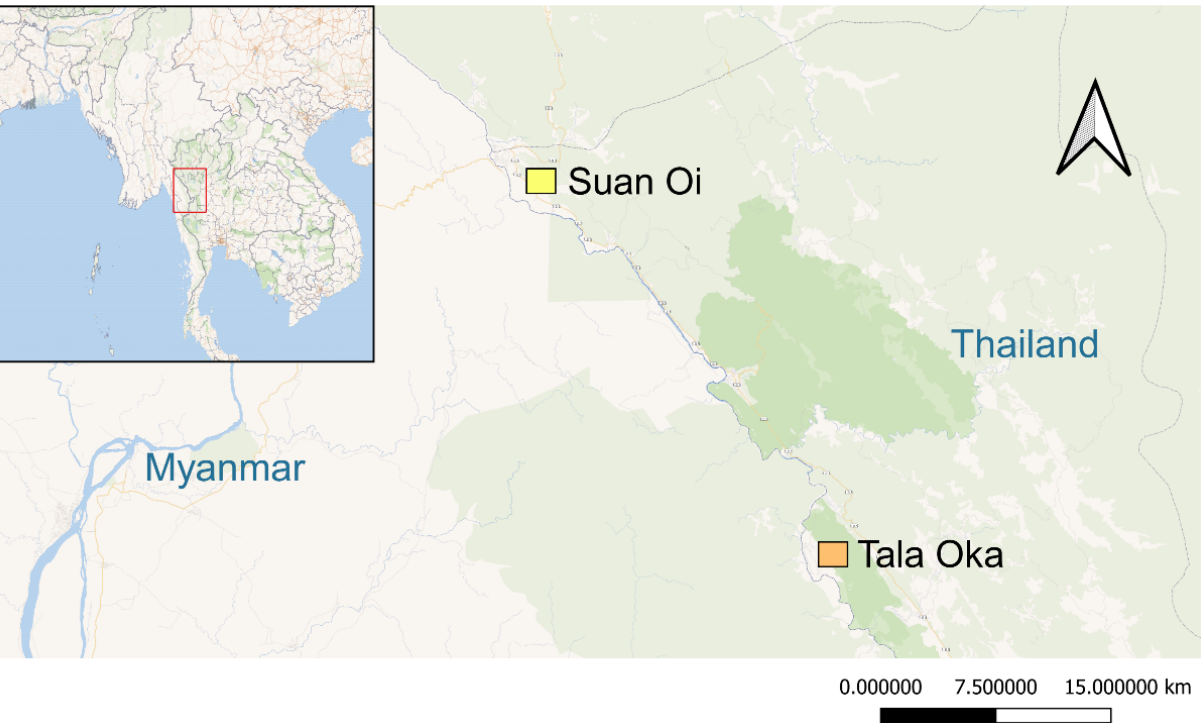
Figure 1. Map of Tak province (red frame) and collection sites of Anopheles spp. and Ae. aegypti , Suan Oi (SO); Tala Oka (TO). These two villages are located along the Thai–Myanmar border.